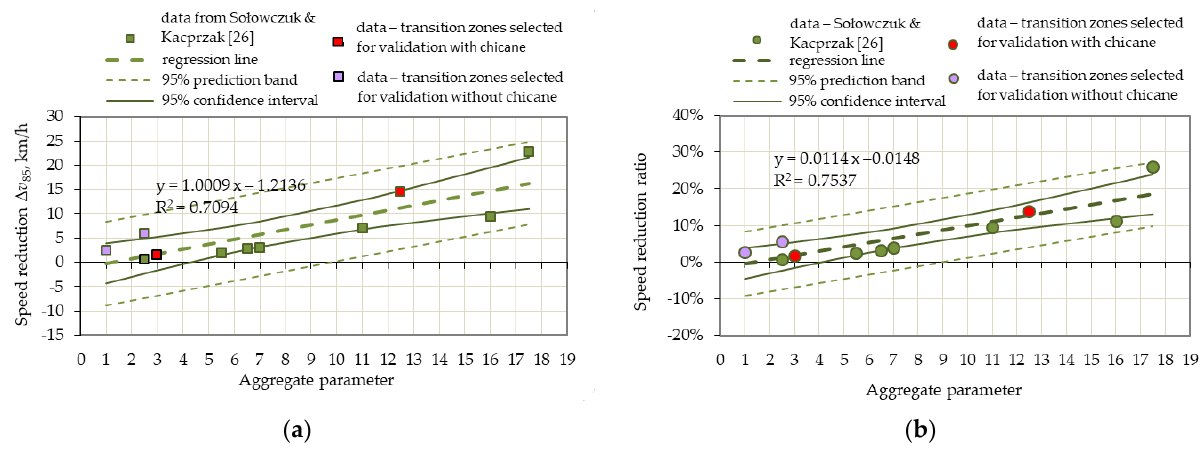
Figure 9. Linear regression function in the study area No. 1 defining the relationship between the aggregate parameter and speed reduction: ( a ) Speed reduction ∆ v 85 ; ( b ) Speed reduction ratio SRR. Source: own work of the authors.